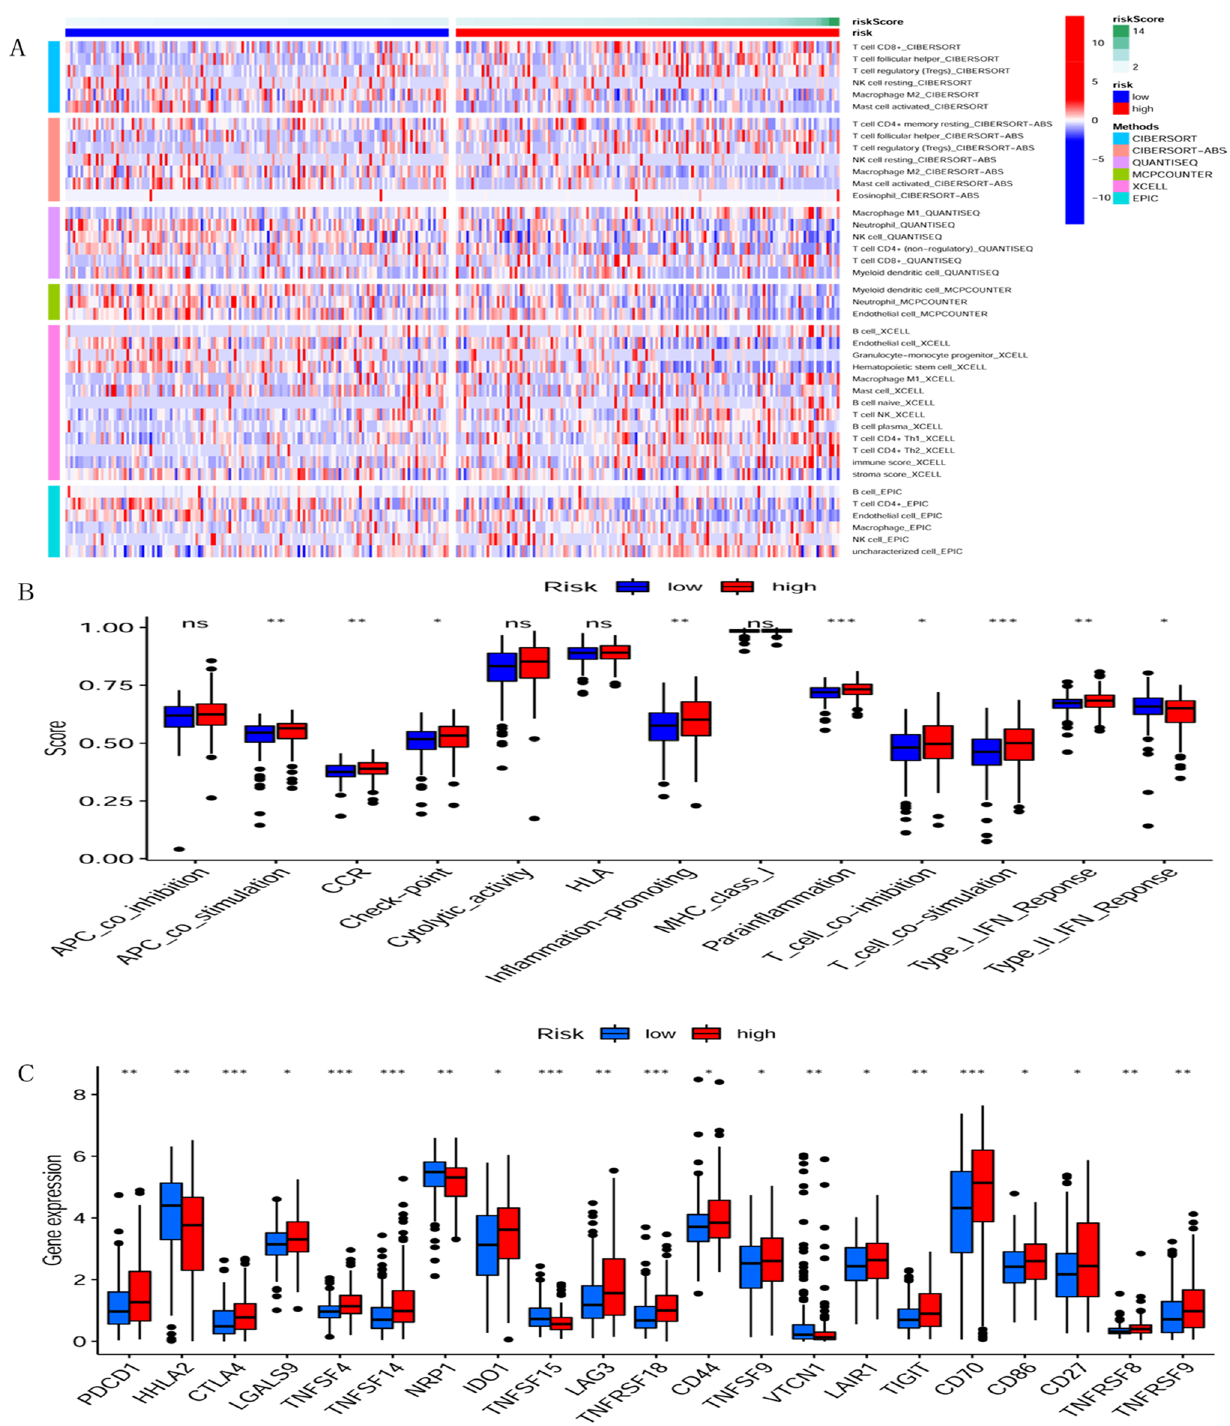
Figure 9. Immunological analyses. Model calculations divided the samples into high-risk and low-risk groups. The two groups were analyzed for differences in Immune cell infiltration, Immune function analysis, and Immune checkpoint. ( A ) Immune cell infiltration analysis. Calculate the correlation between immune cells and the two groups of samples at high and low risk by six different algorithms. ( B ) Immune function analysis. The differences between high and low-risk groups in different immune functions were analyzed. Where blue indicates the low-risk group and red indicates the high-risk group. ( C ) Immune checkpoint analysis. The differences in the expression of immune checkpoints in the high and low-risk groups were analyzed, where blue indicates the low-risk group and red indicates the high-risk